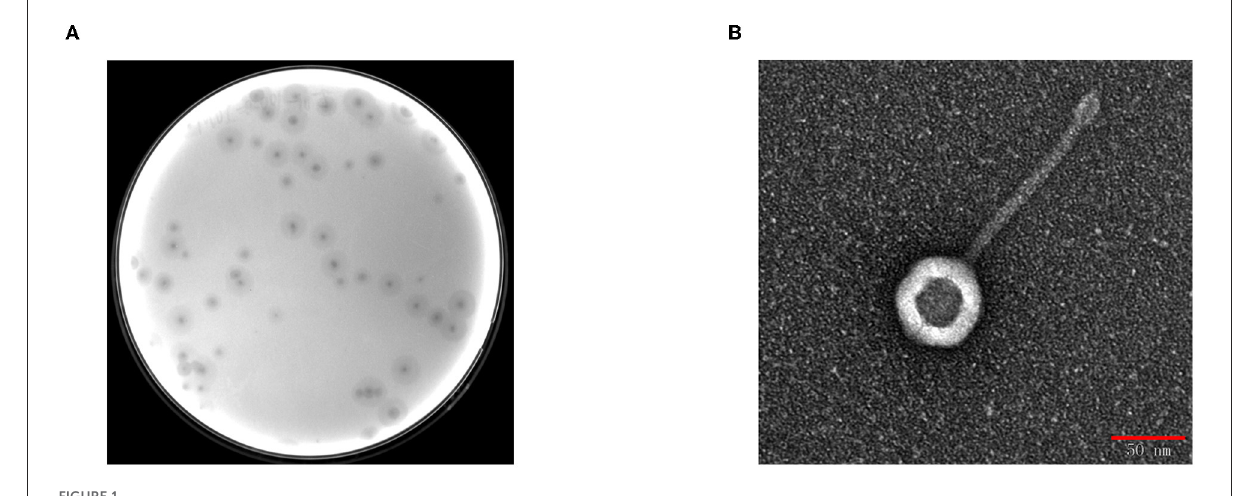
FIGURE1 Plaques morphology of bacteriophage BUCT541. (A) Phage plaques formed of BUCT541 on the lawn with K. pneumoniae S-2007; (B) Transmission electron micrograph image of